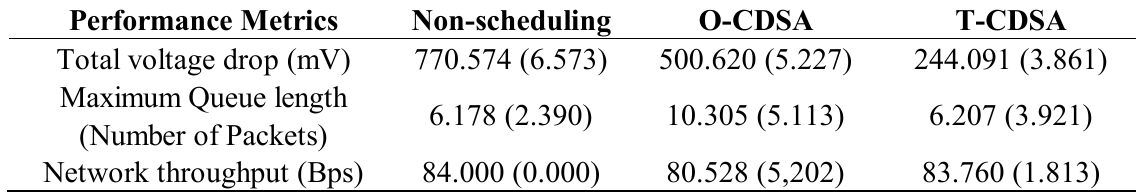
Table 5. Performances comparisons of the three schemes in a WSN testbed.